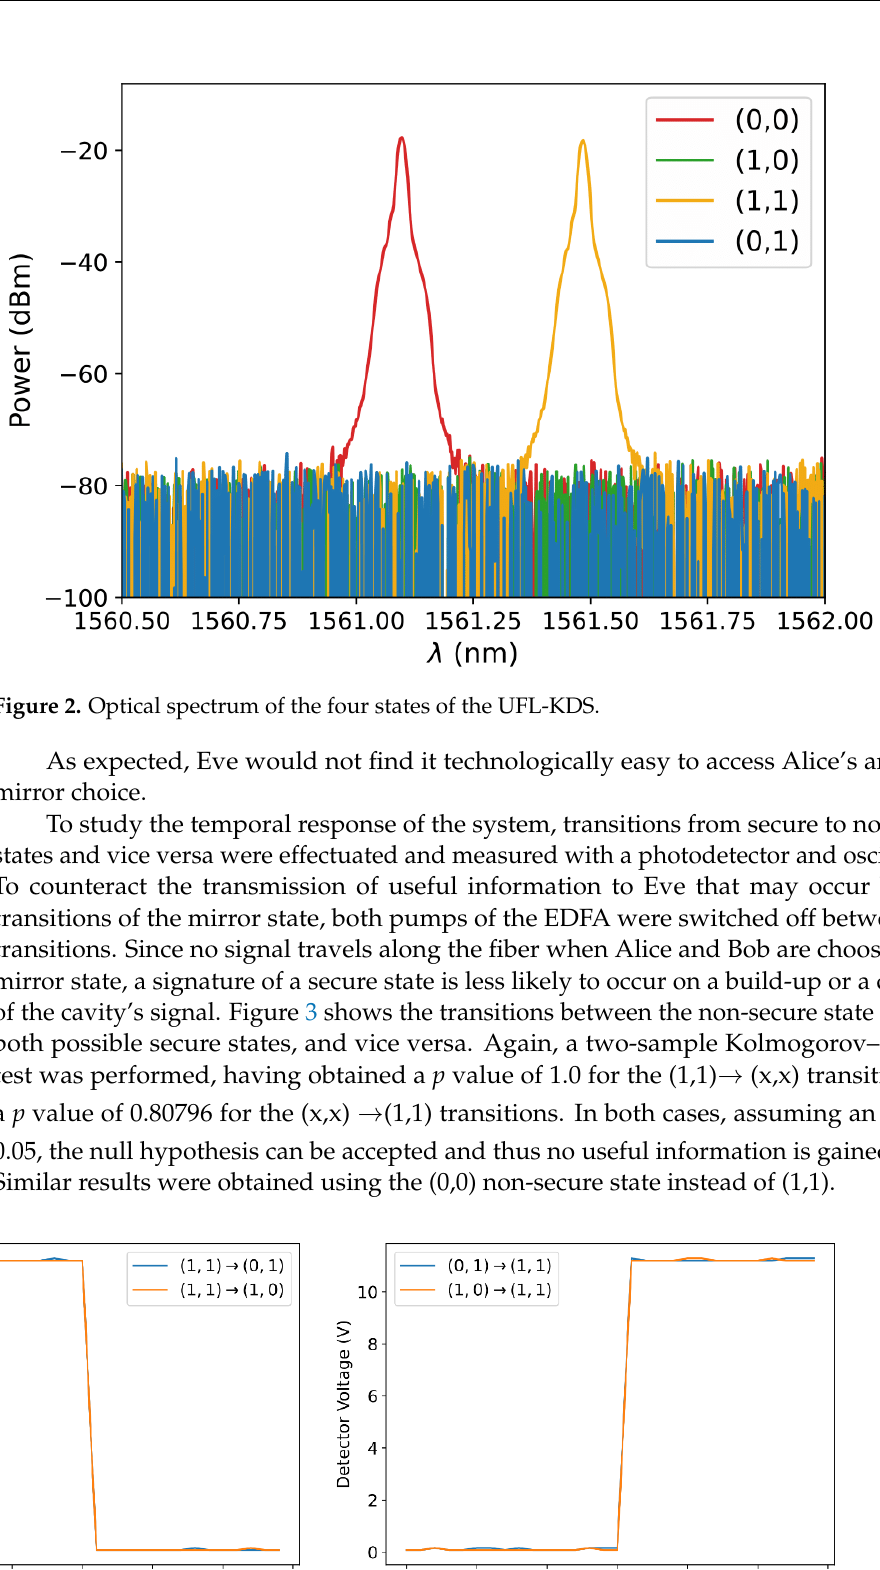
Figure 3. Cavity signal when transitioning from: ( a ) non-secure to secure states and ( b ) vice versa.